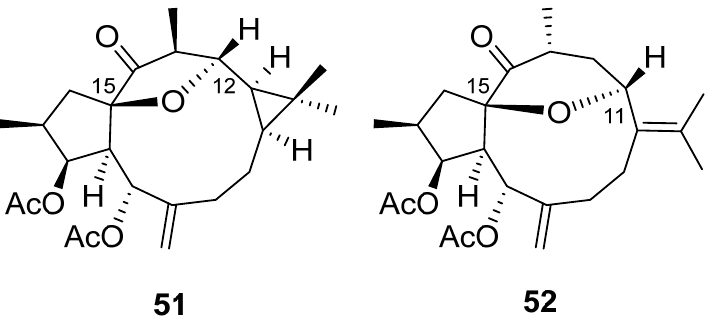
Figure 7. Chemical structures of compounds 51 – 52 .